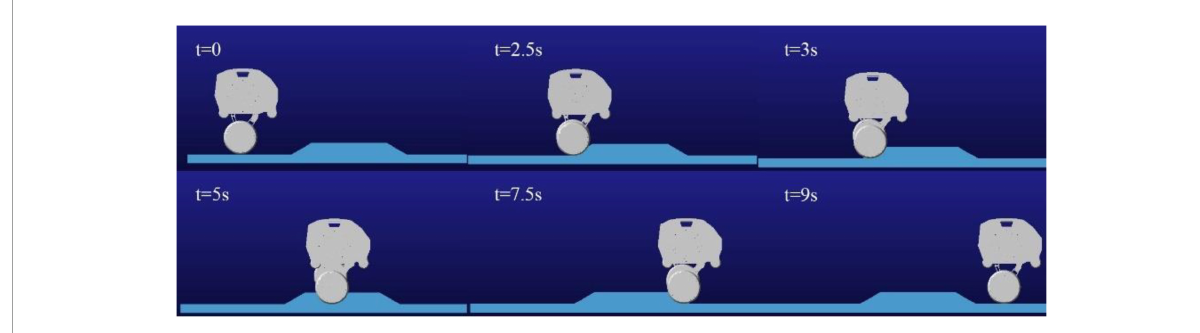
FIGURE18 Process diagram of single-leg obstacle crossing.